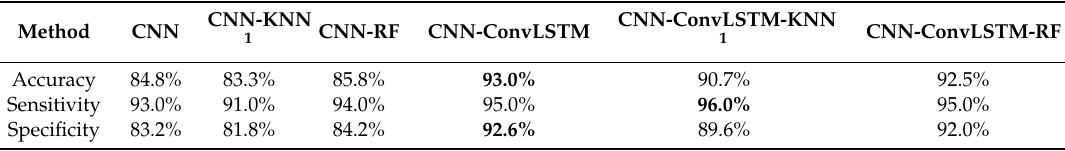
Table 3. Accuracy, sensitivity, precision, and specificity of the fall detection schemes.